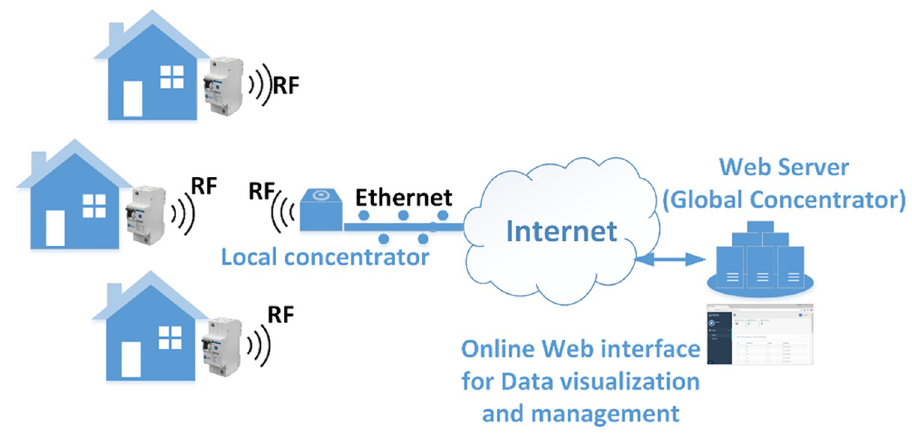
Fig 4. Overview of the communication system